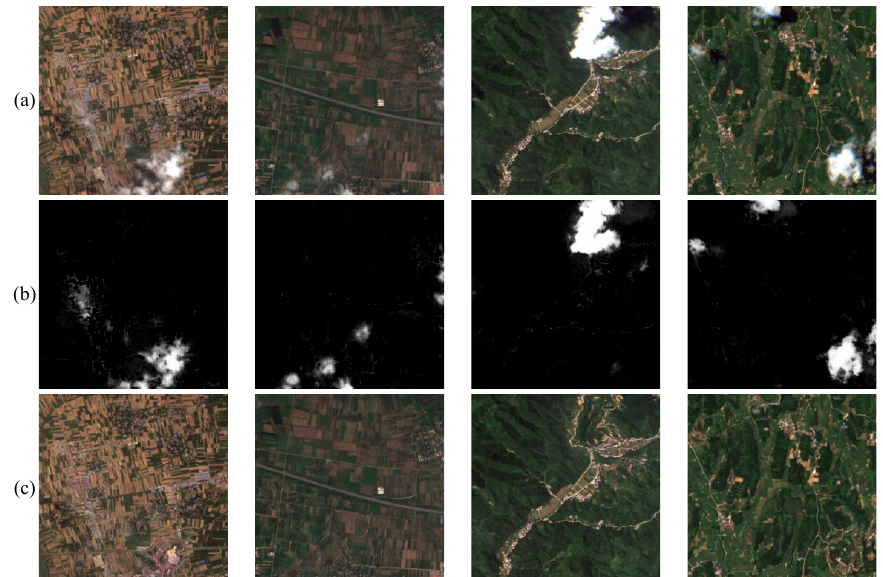
Figure 7. Successful example results of our method on Sentinel-2A image patches at 256×256 resolution. (a) Input image. (b) attention map. (c) Generated cloud-free image.